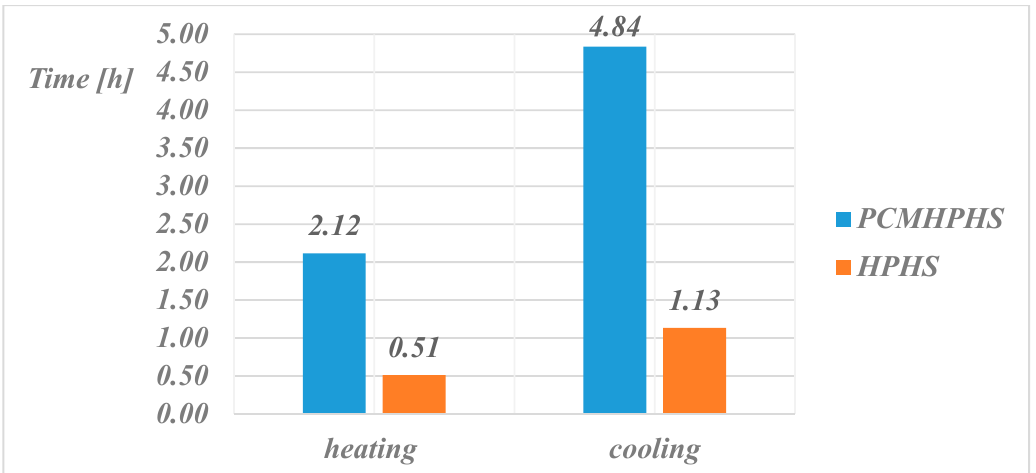
Figure 10. A section through the PCMHPHS during the cooling phase.